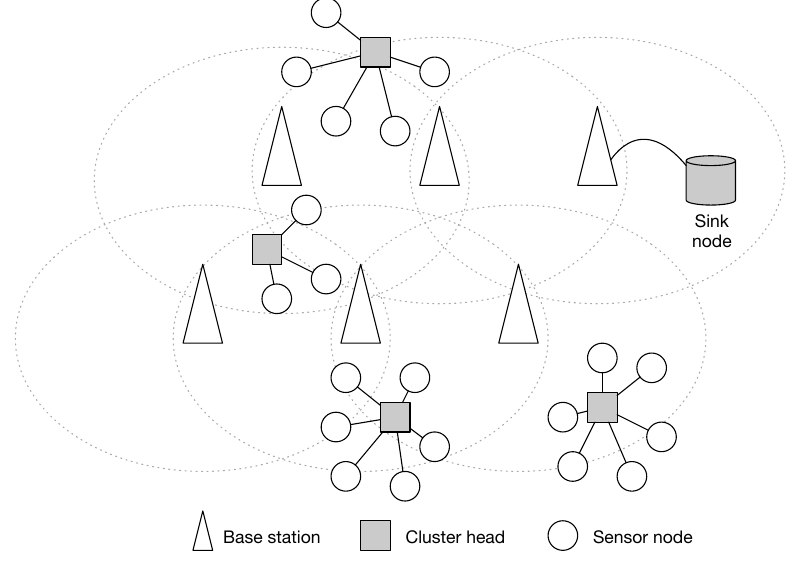
Figure 1. Cluster head in hybrid wireless sensor